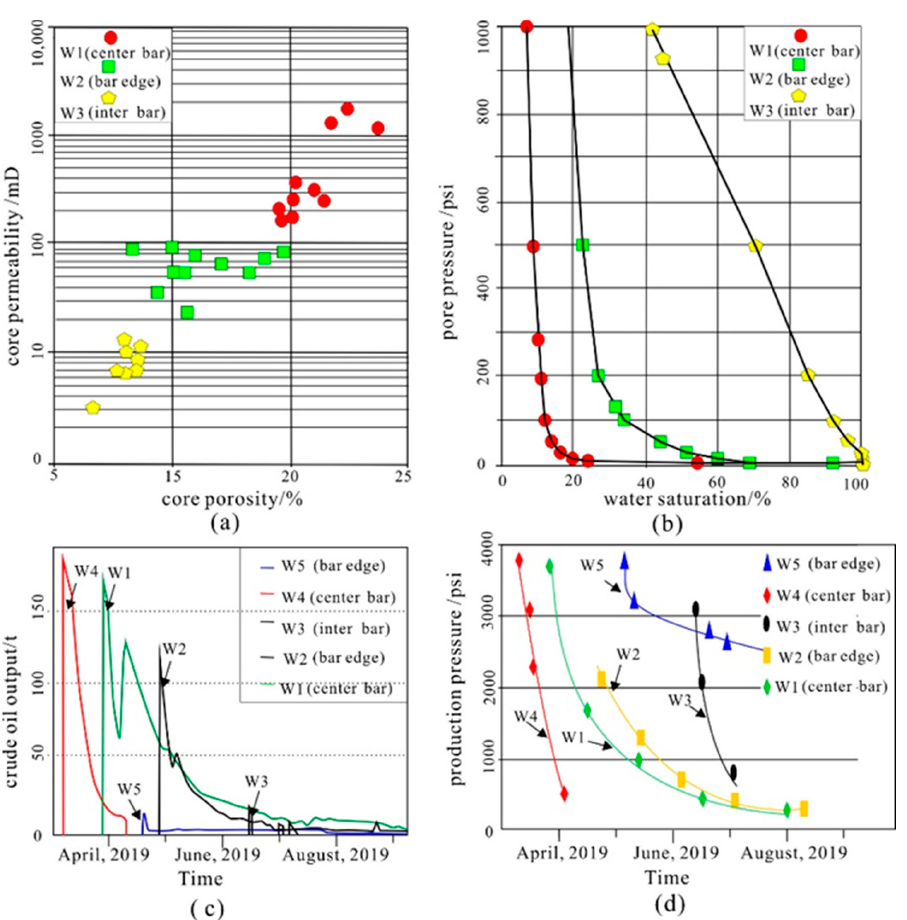
Figure 8. Production dynamic test analysis in the B member sandbar oil well. ( a ) Cross map between core porosity and permeability, ( b ) capillary pressure curve, ( c ) crude oil–daily output curve, ( d ) production–pressure curve, the wells’ location is seen in Figure 1c.